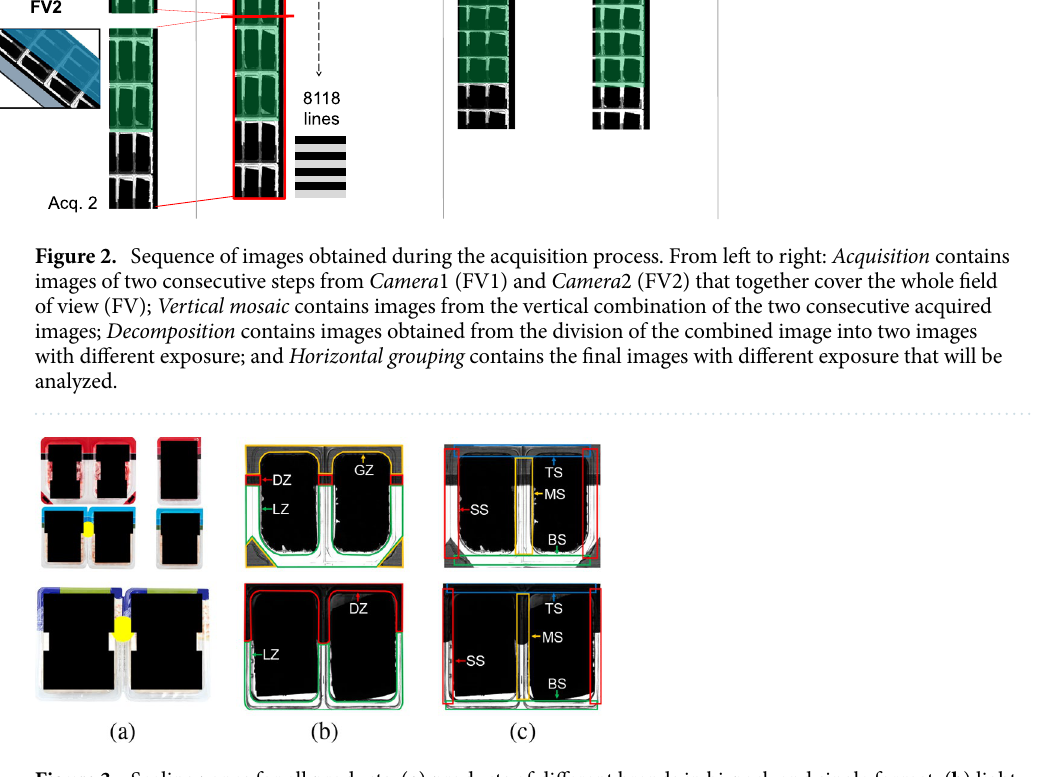
(ii) there is a large piece of food near the sealing that, despite not being in the sealing, will have an undesired